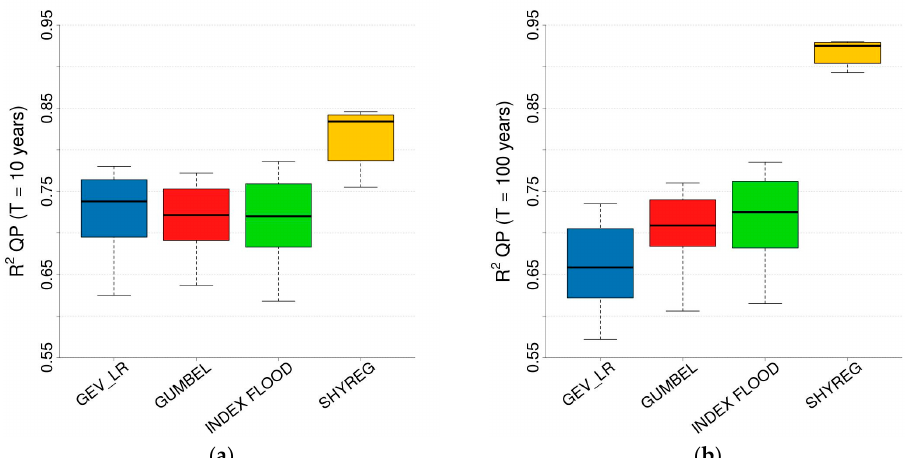
Figure 2. Distribution of the R 2 criterion for different quantiles with all the regionalisation techniques pooled. ( a ) 10-year return period peak flow; ( b ) 100-year return period peak flow.